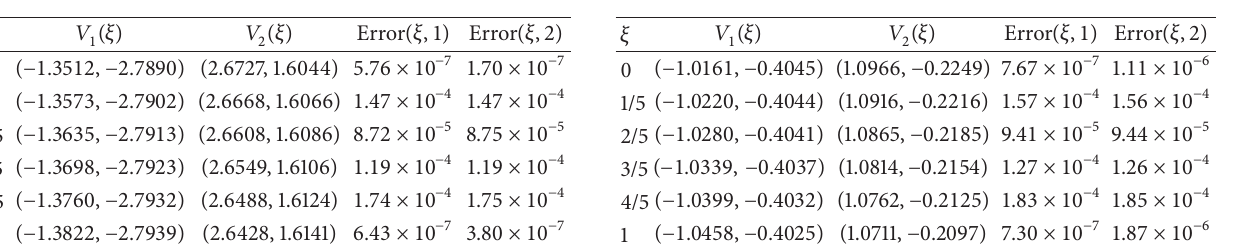
Table 1: Solution and relative error for Example 1.